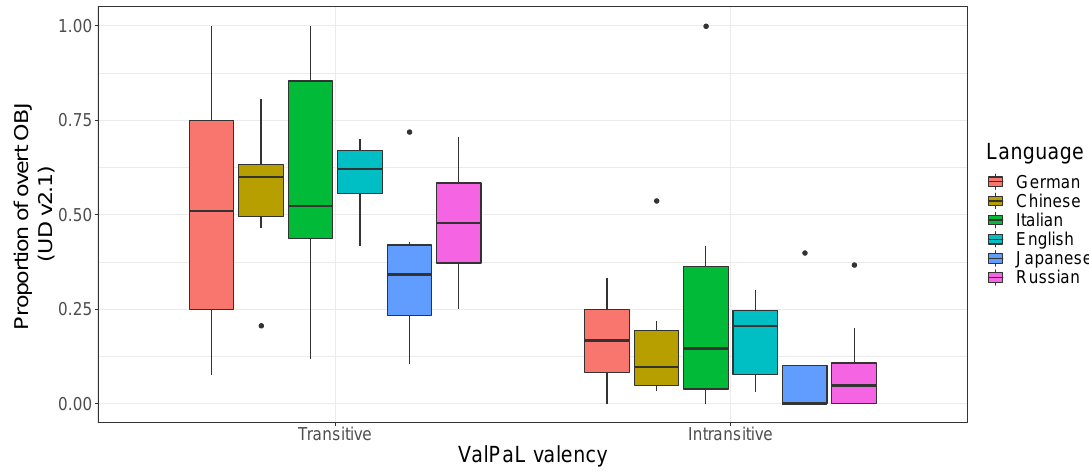
Figure 2: Distribution of verb meanings in six languages (color-coded) based on overt object-taking occurrences in corpus data (UD) as a measure of transitivity prominence ( y axis) set off against their classification in a valency database ( x axis). Lan- guages are sorted from most to least transitive, averaged across verb